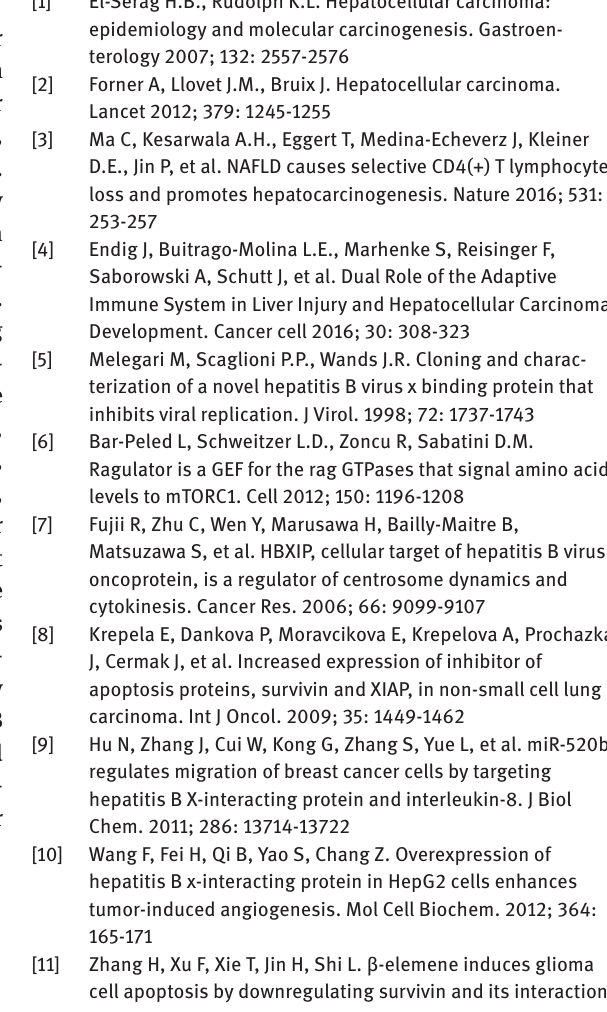
Figure 4: Overexpressed GLUT1 is associated with high level of LAMTOR5 in clinical HCC tissues. The correlation between GLUT1 and LAMTOR5 was evaluated in twenty-one cases of clinical HCC samples (Pearson′s correlation coefficient, R2= 0.8311, **P <